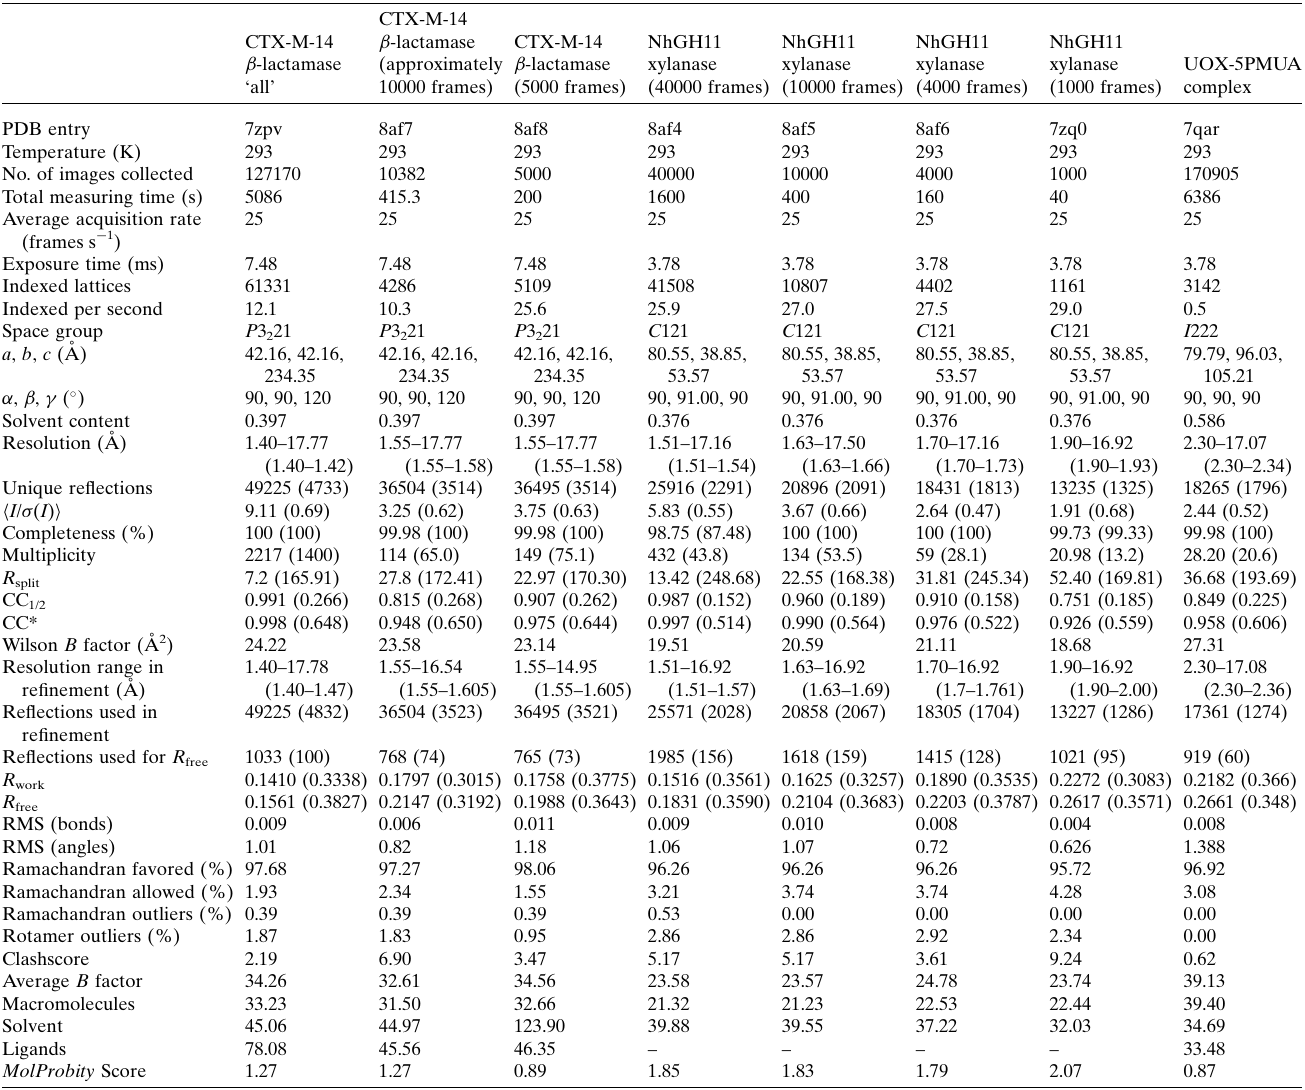
Table 1 Data collection and refinement statistics. Values in parantheses are for the highest-resolution